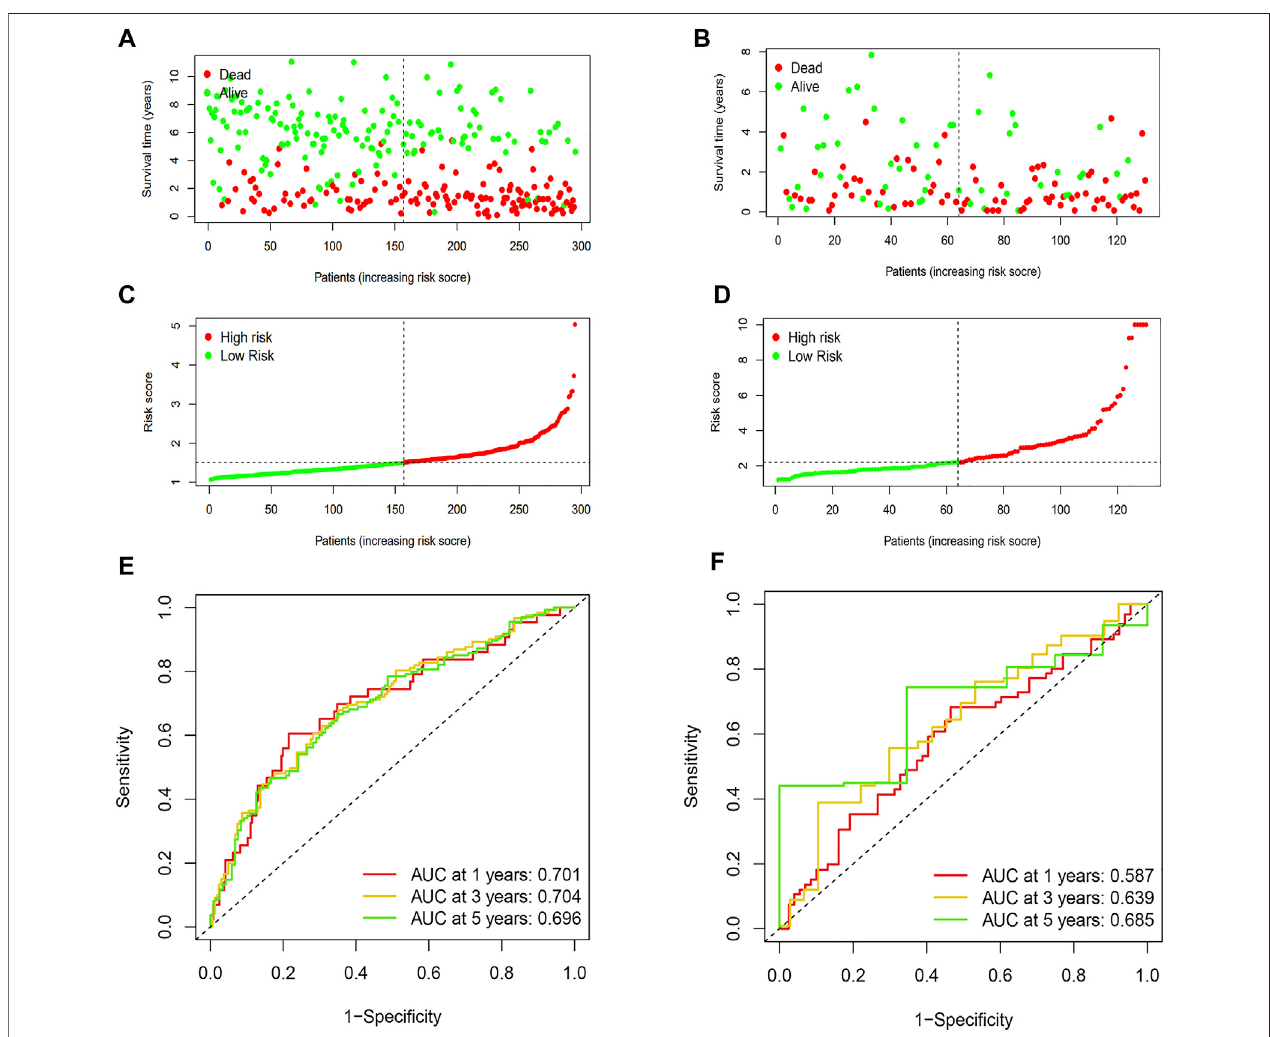
FIGURE 7 | Prognostic analysis and performance assessment of TARGET and TCGA databases. (A) Distributions of risk scores of AML patients in the TARGET dataset. (B) Distributions of risk scores of AML patients in the TCGA dataset. (C) Distributions of the survival status of AML patients in the TARGET dataset. (D) Distributions of survival status of AML patients in the TCGA dataset. (E) ROC curves of m6A-LPS for predicting the 1/3/5-year survival in the TARGET dataset. (F) ROC curves of m6A-LPS for predicting the 1/3/5-year survival in the TCGA dataset.